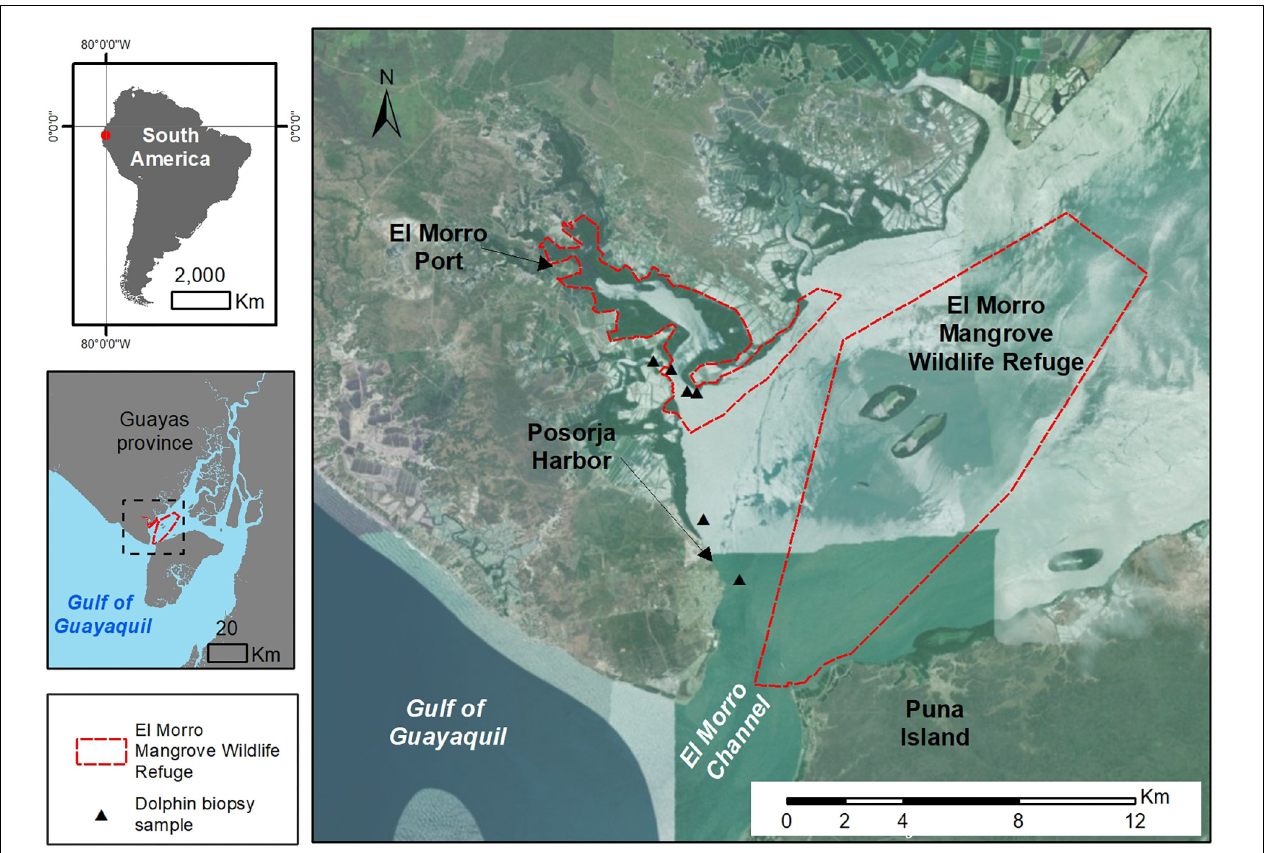
FIGURE 1 | Geographical location of El Morro Mangrove Wildlife Refuge (REVISEM) and surrounding areas (Posorja Harbor, El Morro Channel) in the Estuary of the Gulf of Guayaquil, Ecuador. The map illustrates the study area for biopsy sampling sites (triangles) in REVISEM and Posorja Harbor waters. Mangrove forests and urbanized and rural areas are also